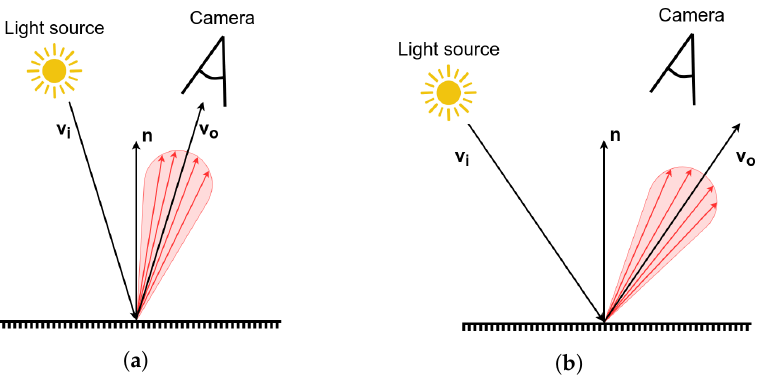
Figure 4. Change in light on a highly specular surface. ( a ) Direct reflection to the camera. ( b ) Reflection in a different